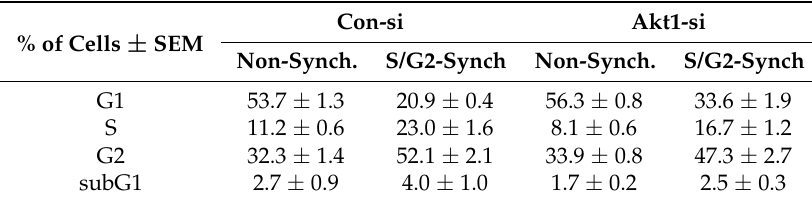
Table 1. Cell cycle distribution after S/G2 phase synchronization. A549 cells were treated with the indicated siRNA and synchronized in S/G2 phase using aphidicolin (5 µ g/mL). In parallel to the clonogenic assays, the cell cycle distribution was determined by flow cytometry ( n = 3, at least 8 data points). Con-si % of Cells ± SEM